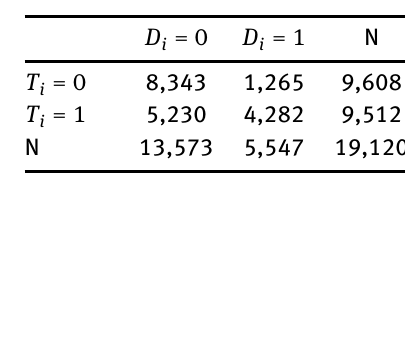
Table B4: Distribution of OHIE participants by status of treatment assignment ( T i ) and treatment received ( D i ).